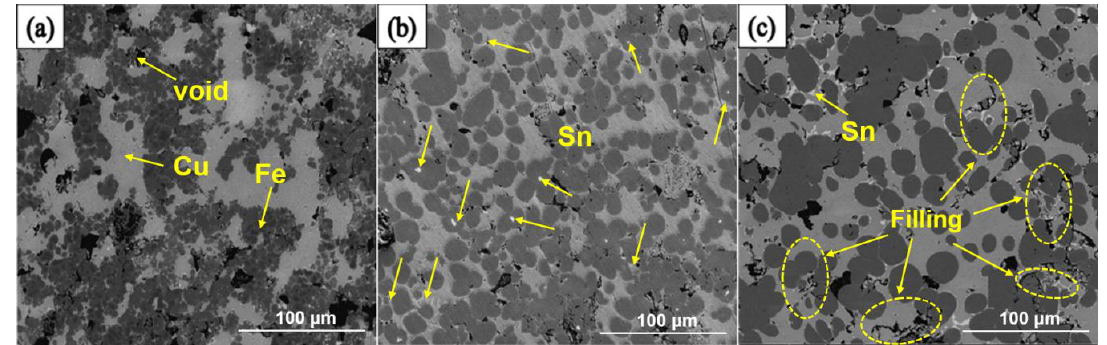
Figure 6. Backscattered scanning electron microscopy (BSE - SEM) diagrams of sintered samples by MPS at different sintering temperatures. ( a – c ) represent 820 °C, 860 °C and 900 °C, respectively.